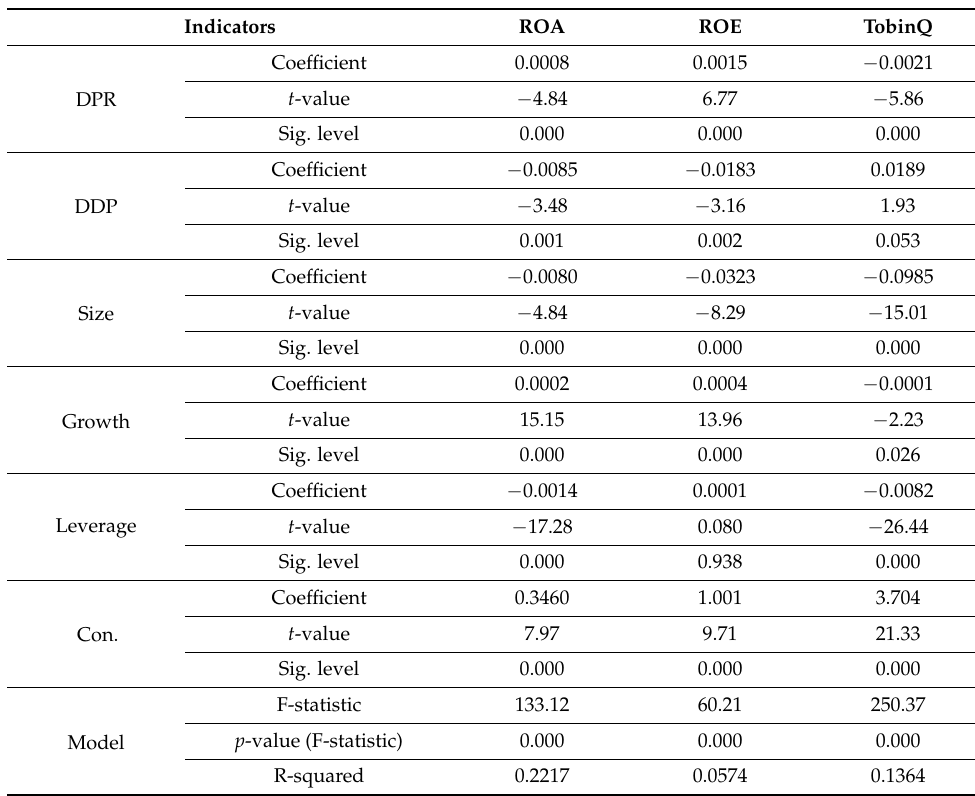
Table 4. Regression results for three dependent